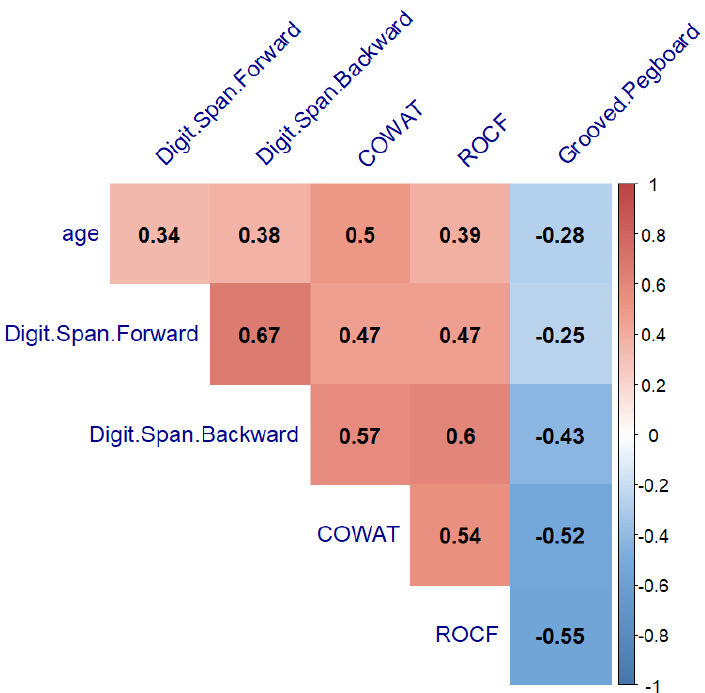
Figure 7. Heatmap of neurocognitive test results and age relationship in Pediatric Brain tumor group showing Spearman’s correlation after FDR correction. COWAT—Controlled Oral Word Association Task, ROCF—the Rey–Osterrieth Complex Figure.